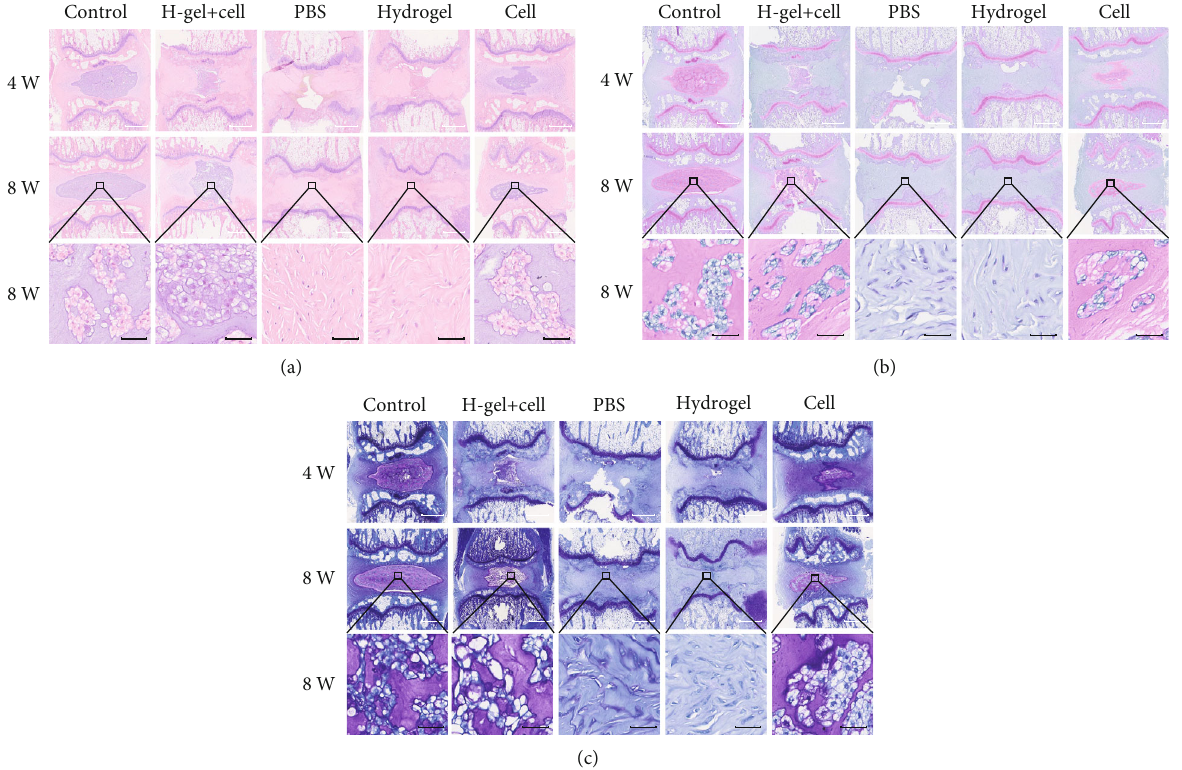
Figure 8: HE, S-O, and toluidine blue staining of di ff erent groups. (a) Representative HE staining at 4 and 8 weeks after injection. (b) Representative S-O staining at 4 and 8 weeks after injection. (c) Representative toluidine blue staining at 4 and 8 weeks after injection. The H-gel+cell group is the hydrogel+cell group. White scale bar = 1mm , black scale bar = 50 μ m